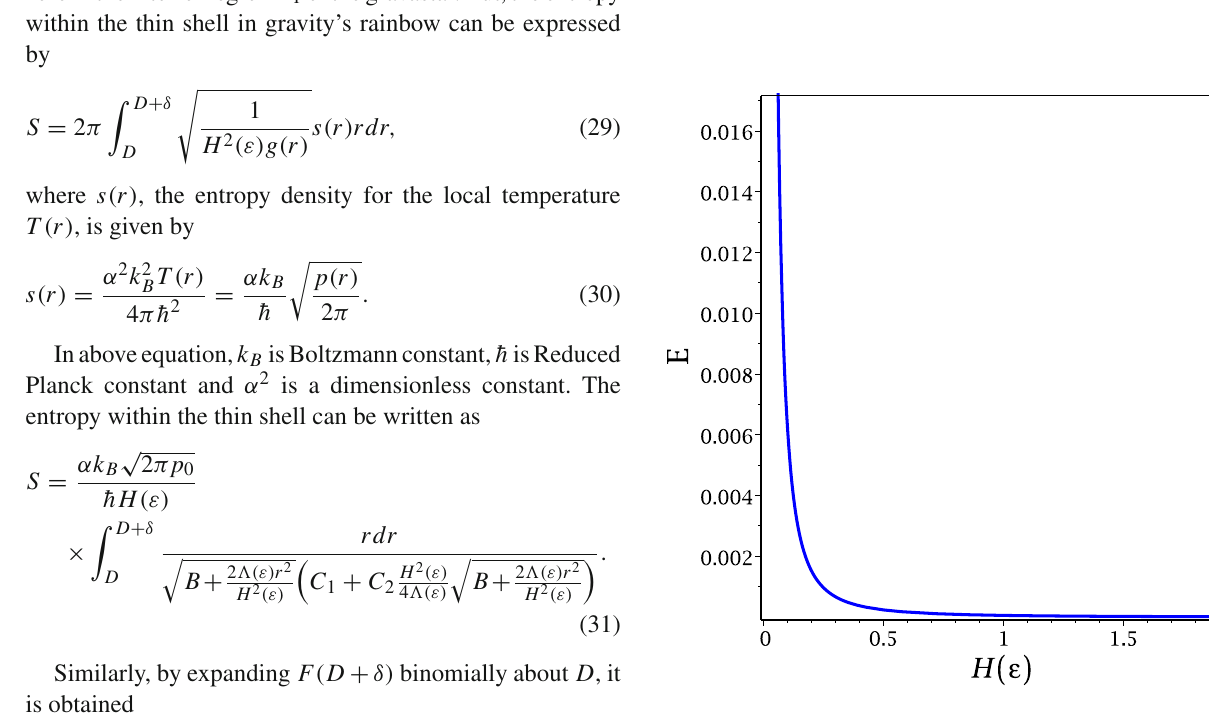
Fig. 2 The energy E vs the rainbow function ( H (ε) ). We have chosen δ = 0 . 01, D = 1, (cid:8)(ε) = − 1, C